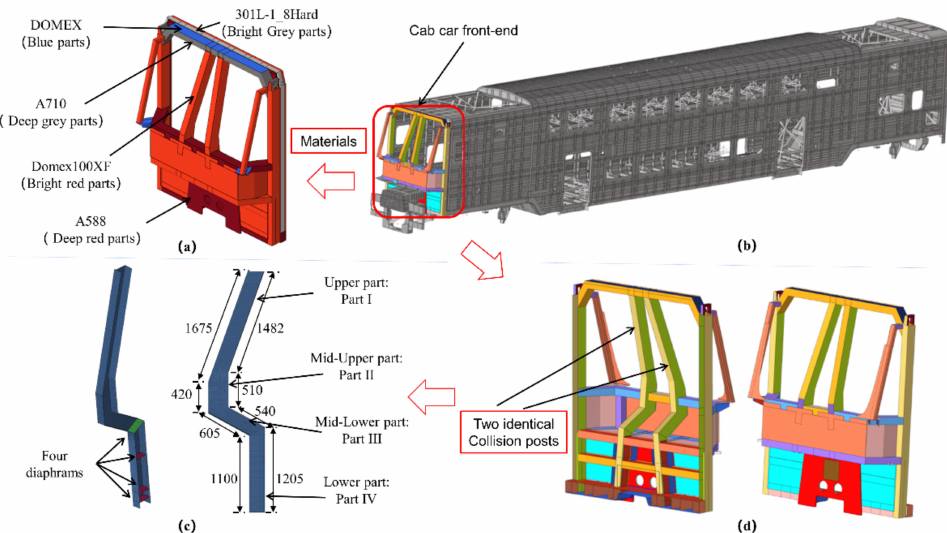
Figure 1. Details for cab car front-end and USCP: ( a ) materials of the cab car front-end; ( b ) bilevel subway car; ( c ) details of USCP; ( d ) cab car front-end of a bilevel subway car.